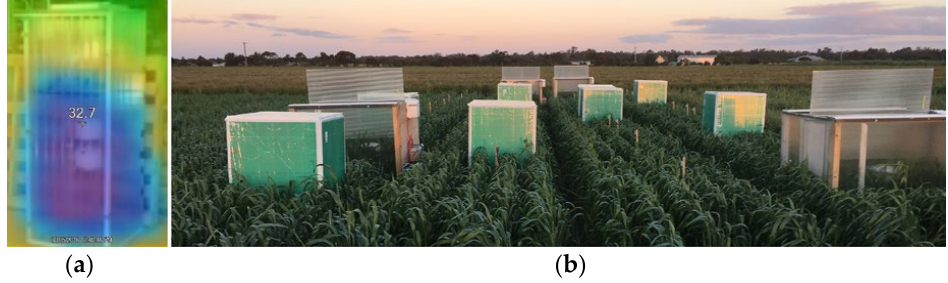
Figure 5. Frost chambers: ( a ) performance testing using visual IR thermometer at 32.7 °F; ( b ) moni- toring the effect of frost on wheat growth using proximal sensors.